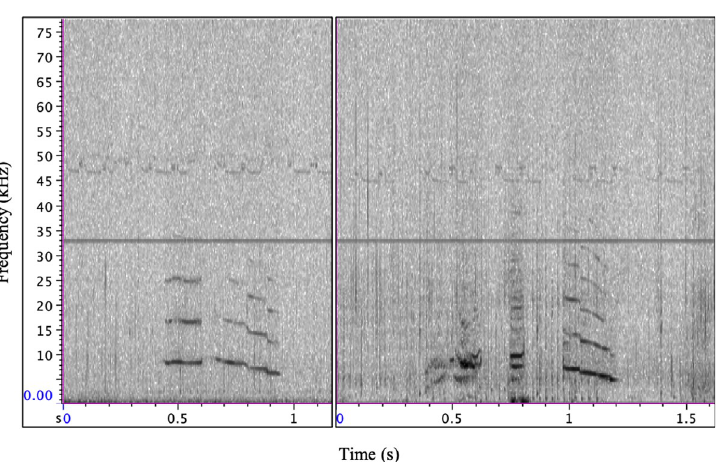
Fig 6. Examples of whistle contours similar to the type C call type. Note the slight deviations in stereotypy and varying spectrogram energy. Spectrogram parameters: DFT size 512, 256 sample hop size, and Hann window 512